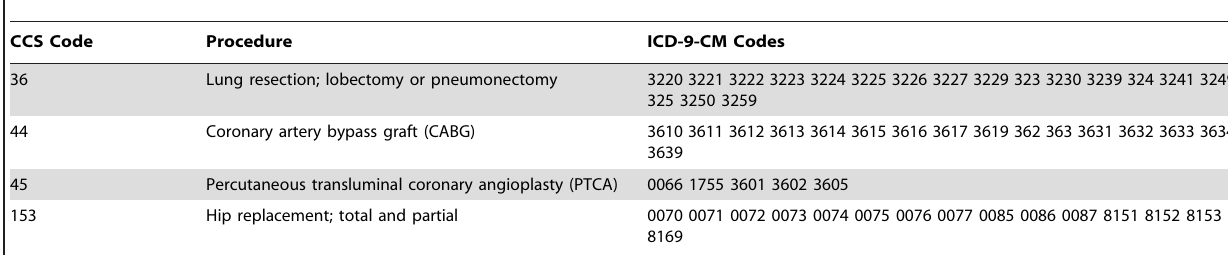
Table 1. ICD-9-CM codes grouped according to clinical classifications software.